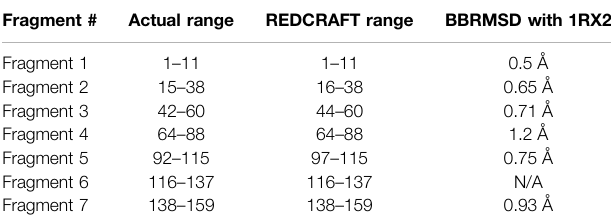
TABLE 3 | The BBRMSD of the different fragments generated through the fragmented run of REDCRAFT.